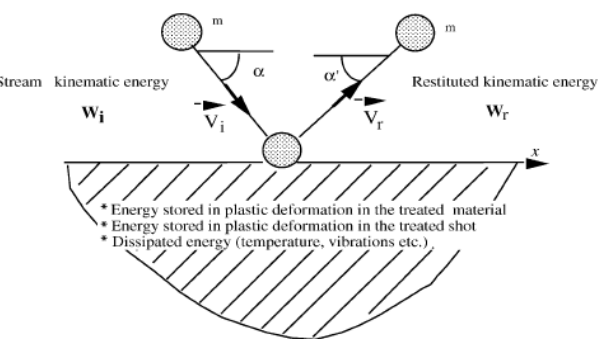
Fig. 1. Energy transmitted during contact shot/material